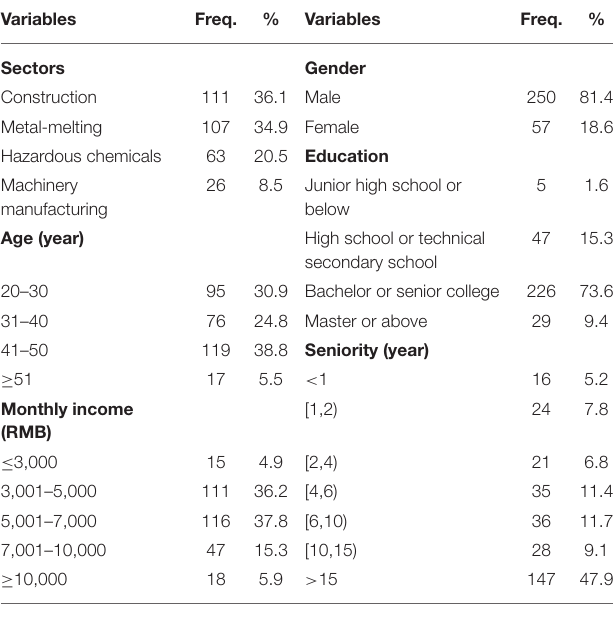
TABLE 1 | Demographic statistics of the sample ( n = 307).